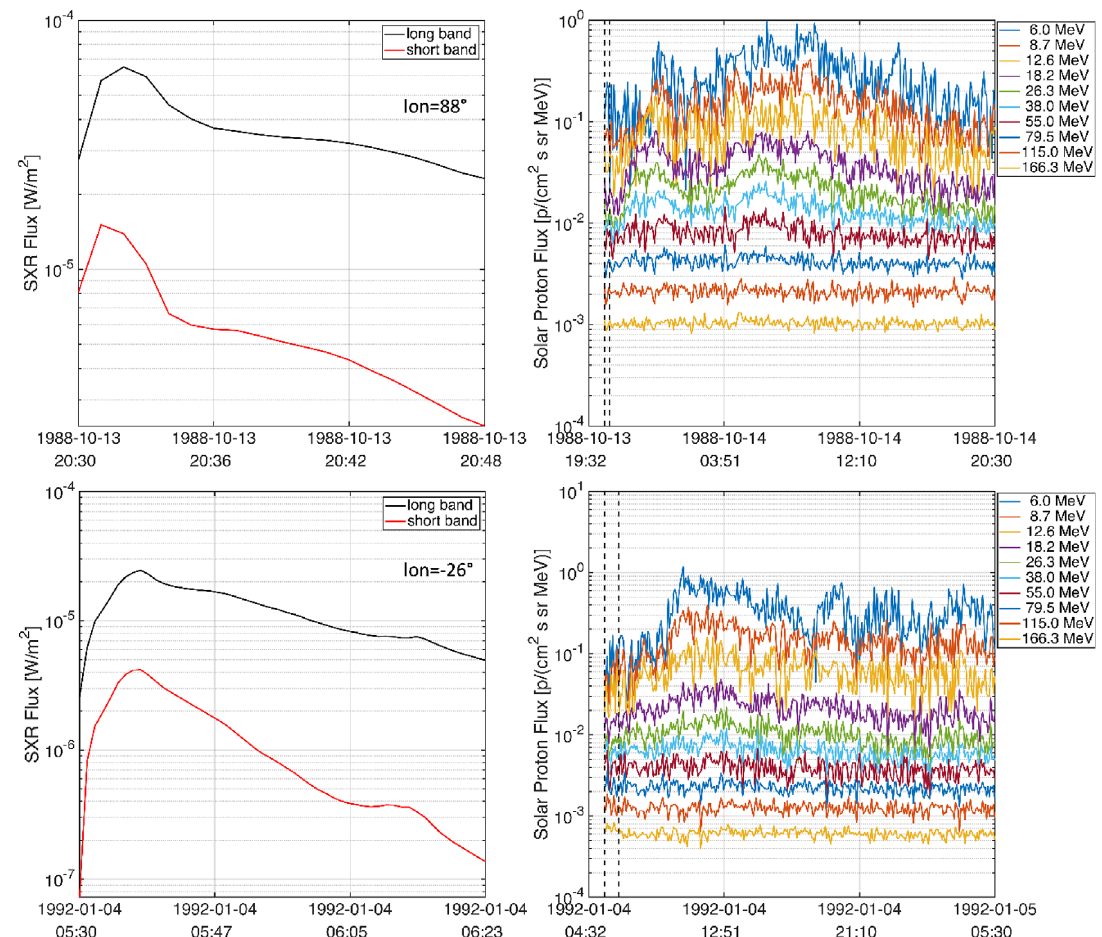
Fig. 11. Top row: on the left are SXR time-series from a western fl are at 88 (cid:3) identi fi ed as a false positive, and on the right the solar proton fl ux time-series in the next 24 h after the start of the fl are. The black dashed lines denote the time of the fl are. Bottom row: similarly for an eastern fl are at (cid:3) 26 (cid:3)